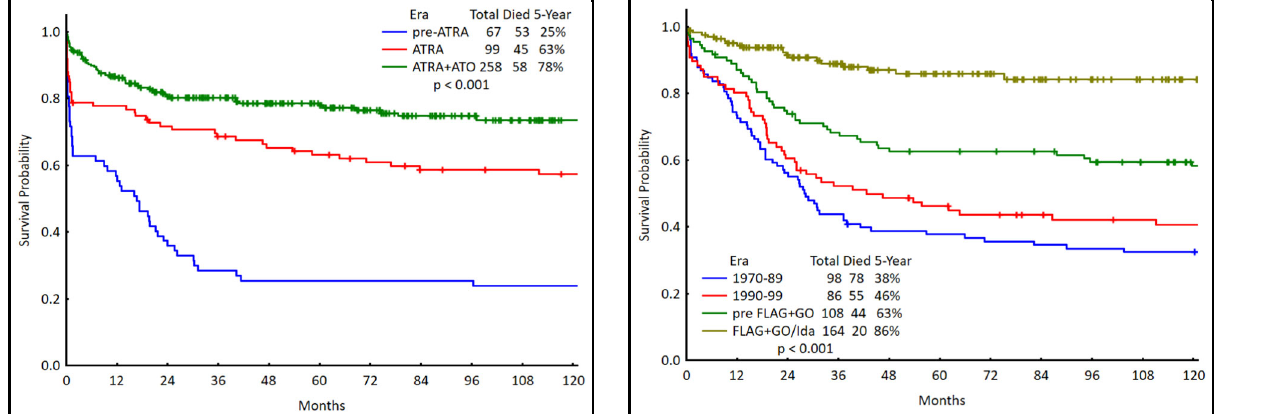
Fig. 2 Survival of acute promyelocytic leukemia at MD Anderson (1970 – 2020).